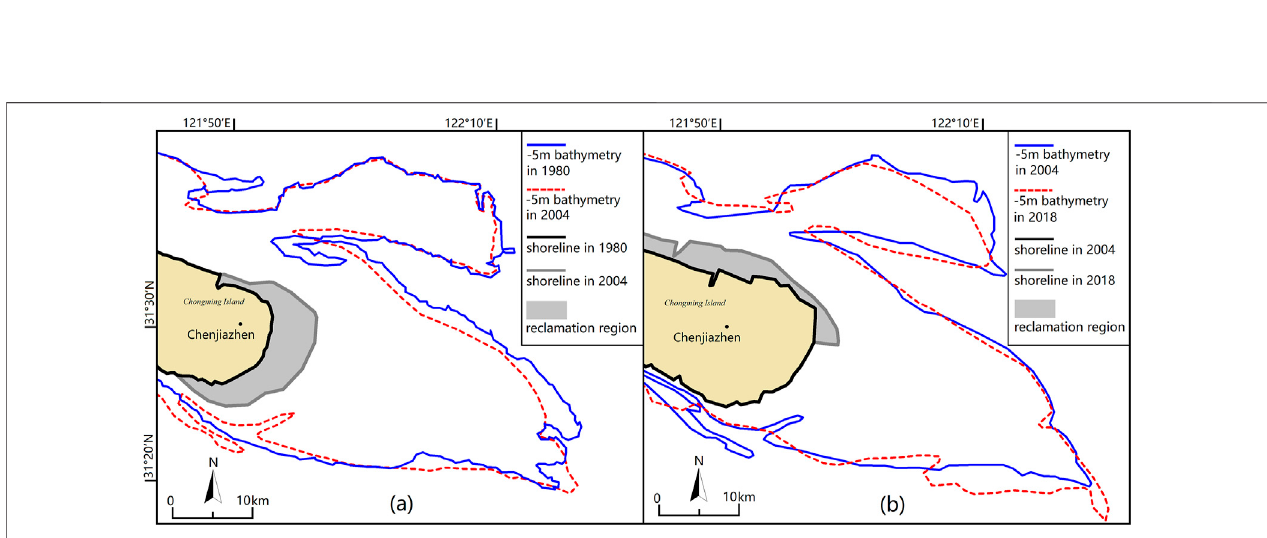
FIGURE10| Theshallowwaterareas(within − 5mbathymetry, WusongDatum)during1980 – 2018(afterYangetal.,2019).Note thattheshorelinesof2004 – 2018 were arti fi cial (by reclamation).